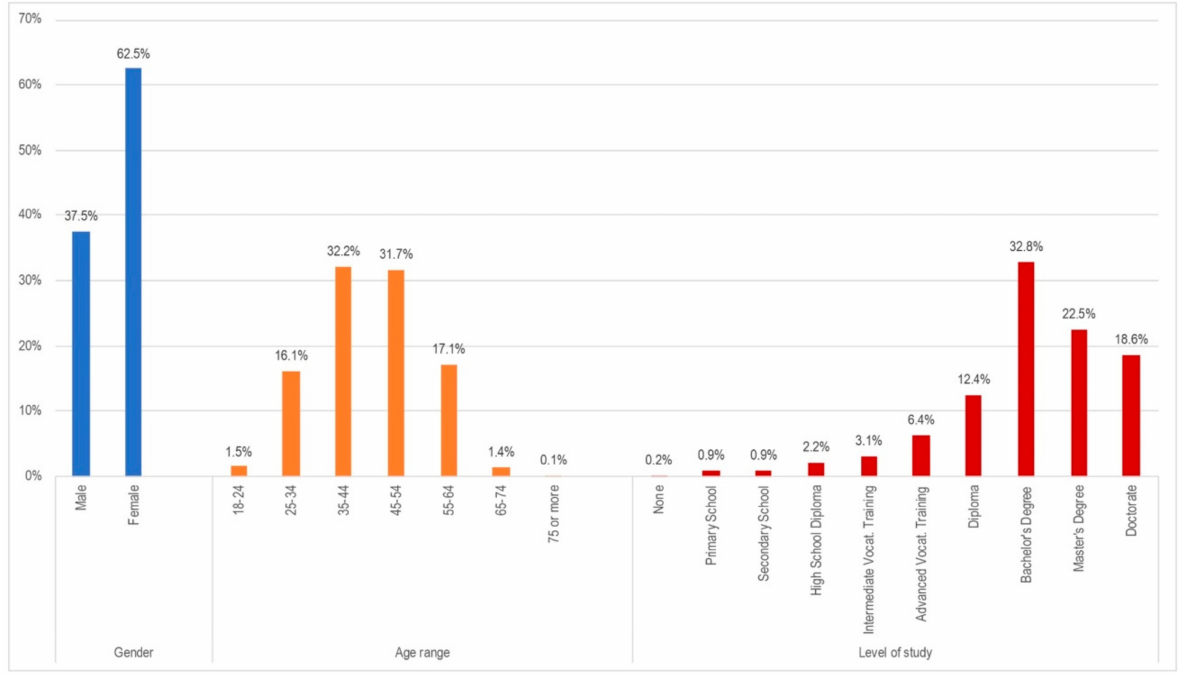
Figure 1. Sociodemographic data of the teleworker-households